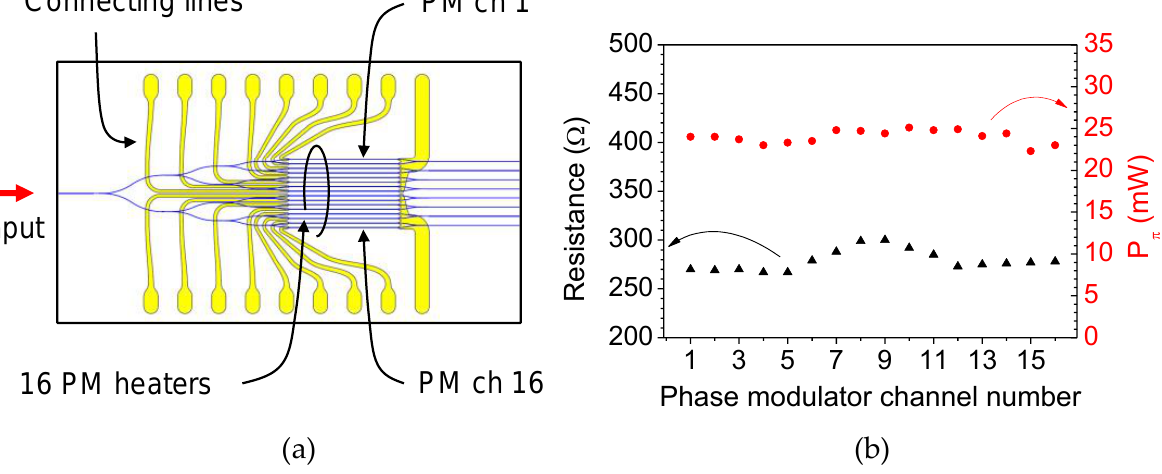
Figure 7. ( a ) Schematic of the 8-ch MZI array device. The PM microheaters on each channel were connected to the pads through connecting lines of different lengths, which led to variation in the heater resistance. ( b ) P of the phase modulators and the resistance of the microheaters on each channel was measured to evaluate the fabrication uniformity of the array device.